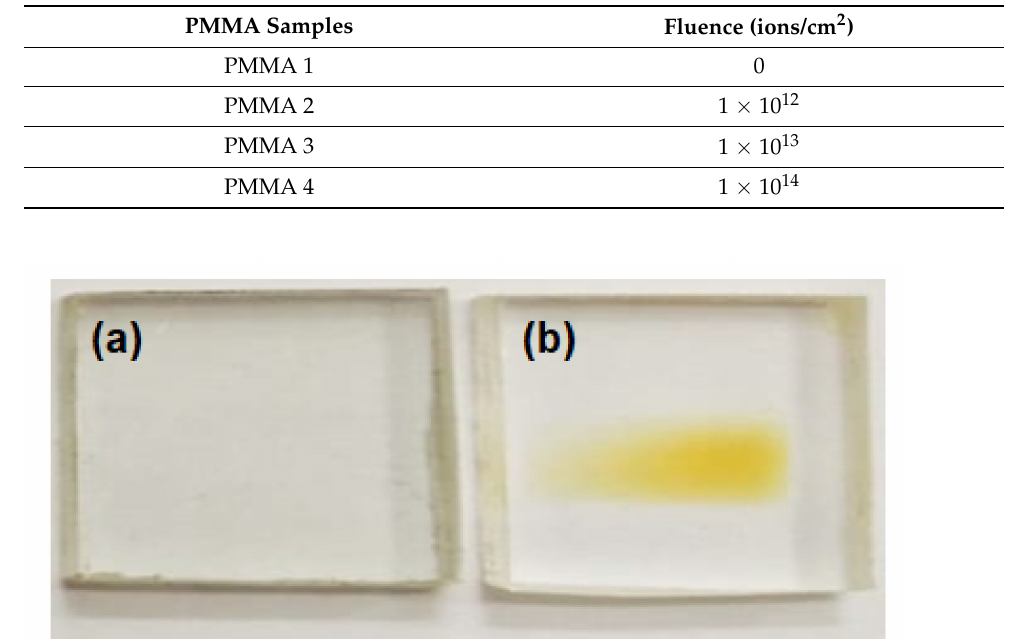
Figure 1. Schematic diagram for ion beam interaction with Polymethylmethacrylate (PMMA) materials. The parameters used for the irradiation of samples are presented in Table 1. The ion beam was focused on a spot of ~1 mm in diameter and, to ensure uniform irradiation, the magnetic scanner continuously scanned over the complete area of the samples. Figure 2 depicts the representation of the pristine and high dose surface of the PMMA samples. Table 1. Fluencies of 500 KeV Cu +1 ions used for ion implantation.